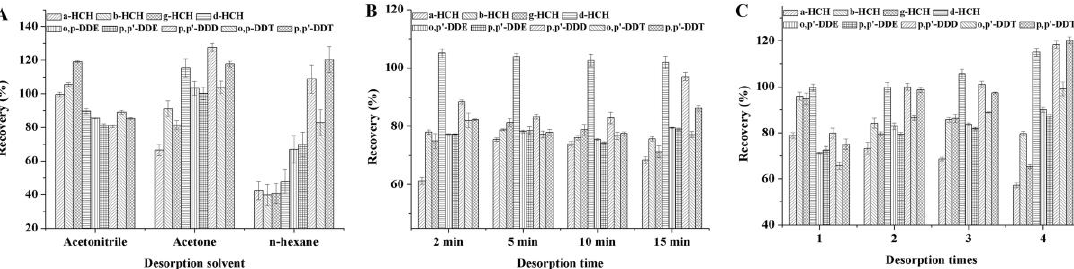
Figure 5. Optimization of the desorption process for 50 µg L −1 organochlorine pesticides using zeolitic imidazolate framework based on magnetic multiwalled carbon nanotubes: ( A ) desorption solvent; ( B ) desorption time; and ( C ) frequency of desorption. Extraction conditions: sample volume, 5 mL; amount of sorbent, 6 mg; and extraction time, 20 min. The error bars show the standard deviation of the mean ( n = 3).